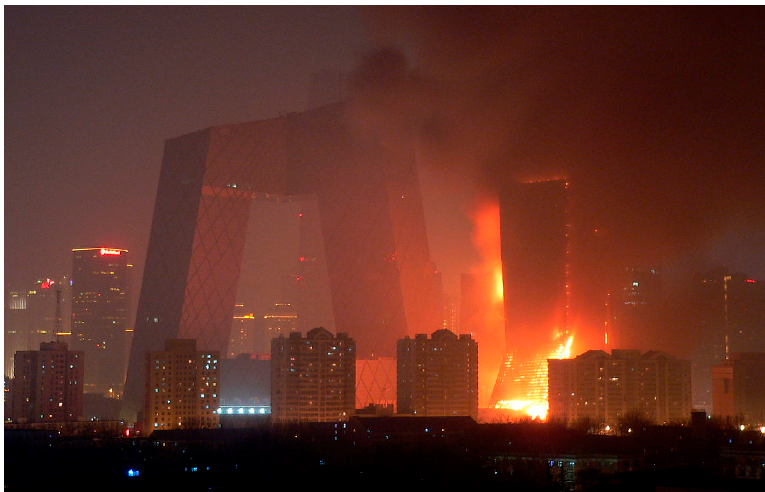
Figure 1. The north wing of the new Television Cultural Centre (TVCC) tower on fire, 09 February 2009. Photograph by Wing, distributed under CC-BY license.